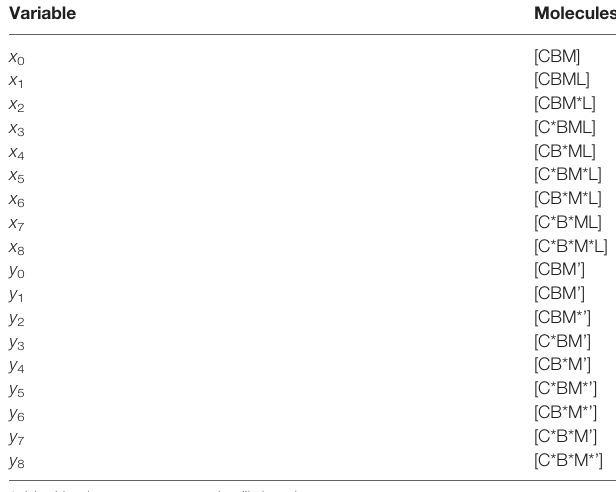
TABLE 3 | Variables in